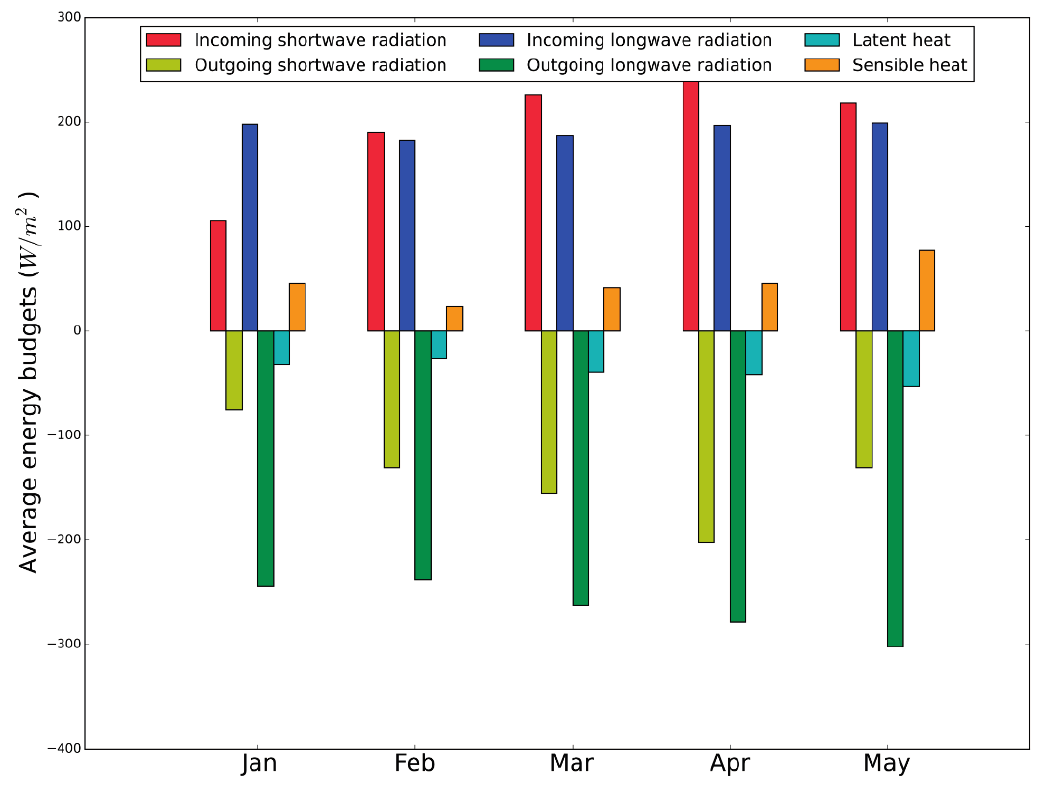
Figure 3. Monthly energy budgets in Yakou station in the study region in the 2008 snow